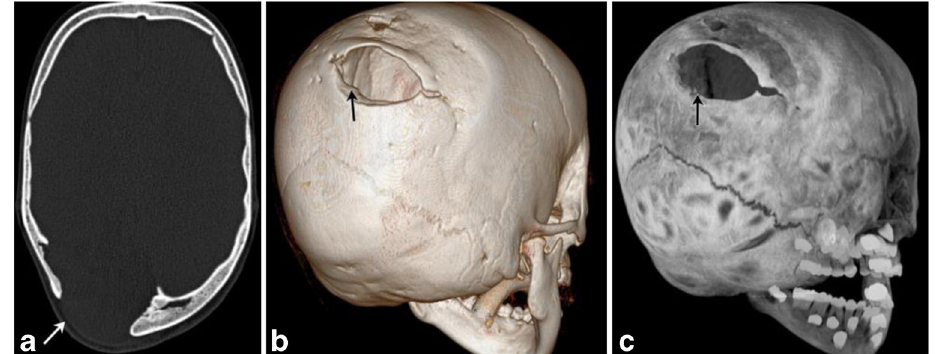
site — an entity called growing fracture or leptomeningeal cyst [volume rendered (b), and MIP 3D reconstruction (c)]. Bony margins at the fracture site are scalloped and